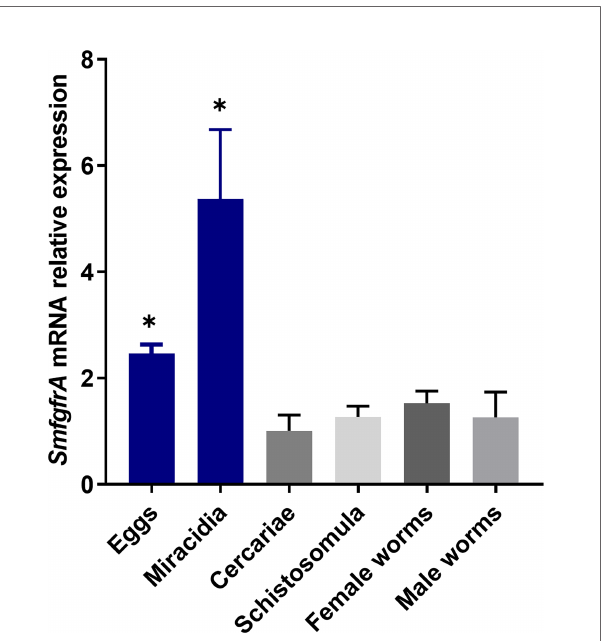
FIGURE 2 | Quanti fi cation of SmfgfrA gene transcripts in different life cycle stages of S. mansoni. The relative expression of SmfgfrA in eggs, miracidia, cercariae, schistosomula, and adult female and male worms were normalized to its expression in cercariae. Data are representative of the mean ± SE of three independent experiments. P values were calculated using cercariae as a comparison group. (* p value ≤ 0.05, One-way